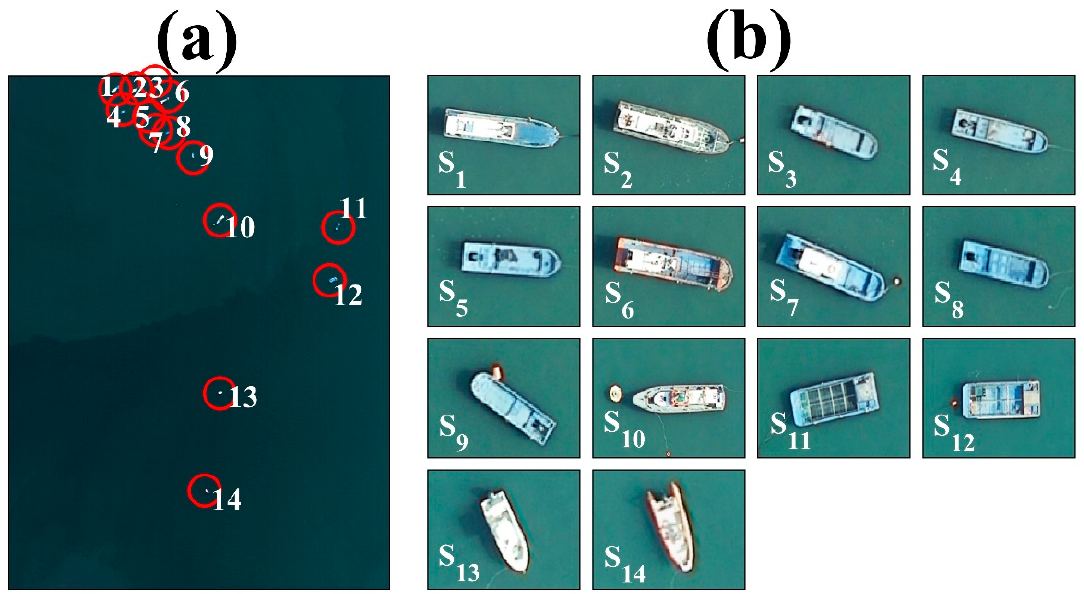
Figure 6. ( a ) Hyperspectral RGB composite image and ( b ) enlarged portion of the red circle in ( a ) using digital mapping camera (DMC).